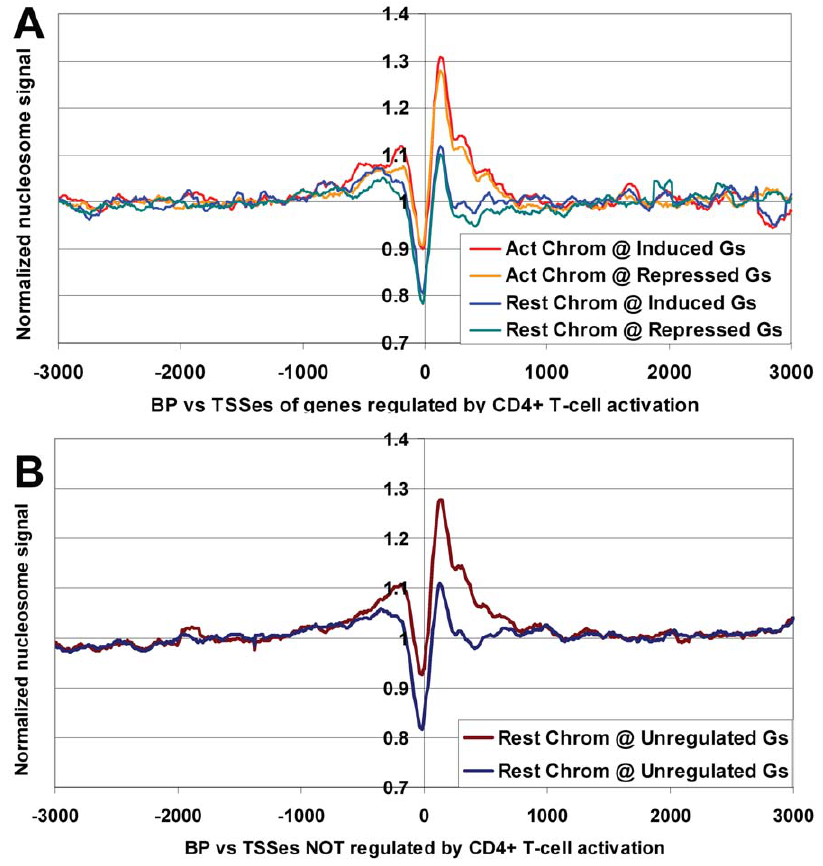
Figure 6. Genomewide increase in promoter nucleosome occupancy upon activation of human CD4 + T cells. Sequence reads from fifty Solexa lanes for resting versus activated human CD4 + T cells [5] were mapped to the human genome, and relative nucleosome frequency versus TSSes determined for genes at least 2-fold induced or at least 2-fold repressed by activation ( A ), or for genes whose expression changed less than 1.5- fold as a result of activation ( B ).